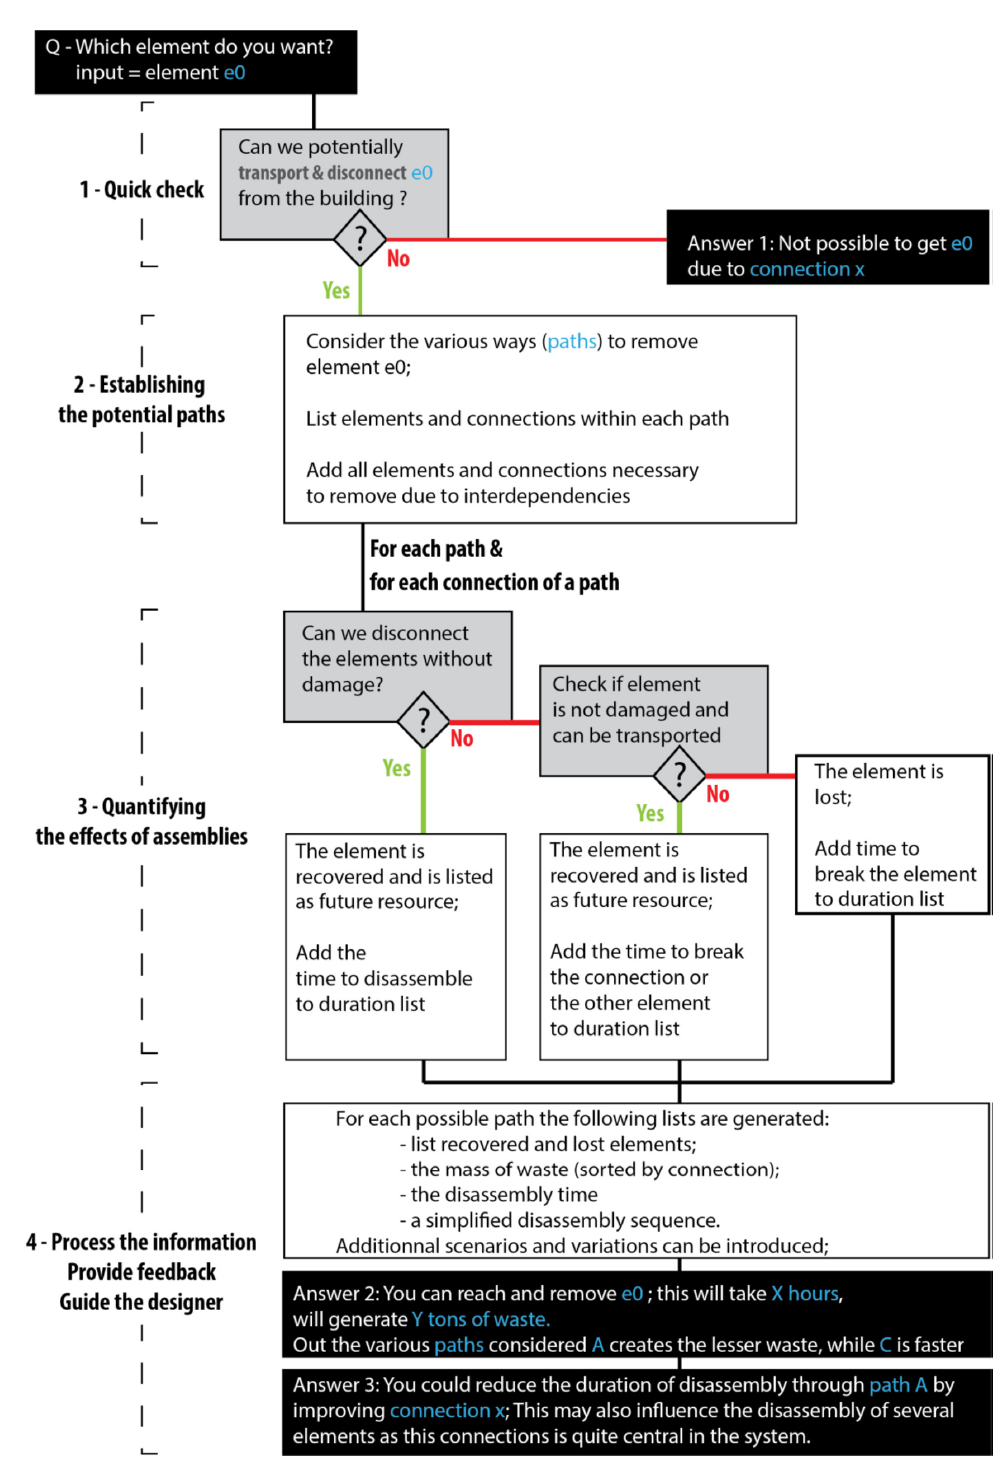
Figure 1. Flowchart of the DNA method. The method is subdivided into four parts: quick check, sequence determination, quantification and processing information, and feedback. This allows each part to be developed and improved independently and ensures future improvements in the